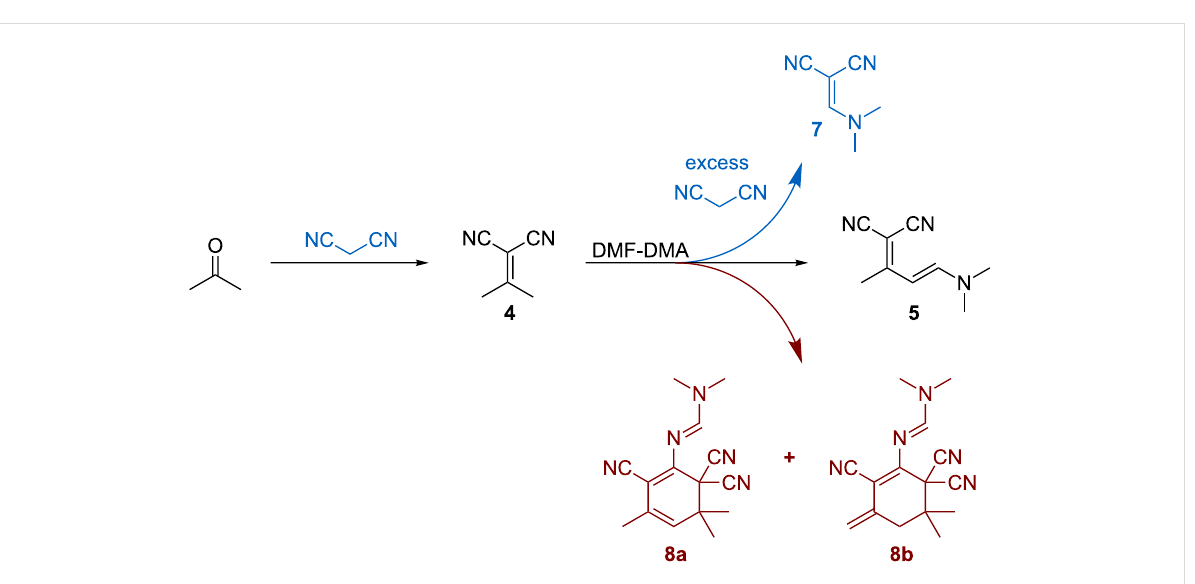
Scheme 5: Several byproducts were observed when producing 5 starting from acetone and malononitrile. 7 is formed from excess malononitrile when the Knoevenagel reaction does not go to completion. The formation of dimers 8a and 8b can begin at any point during the